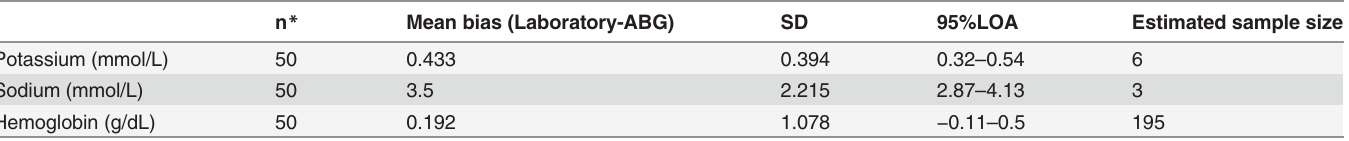
Table 1. Determination of study sample